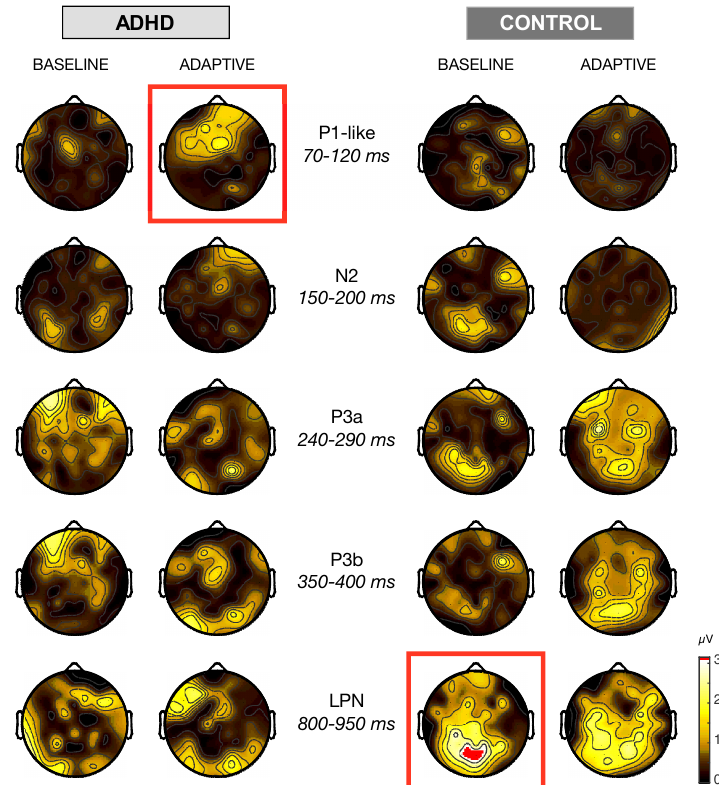
Figure 4. Differential head maps of the topographical distribution of the Grand-Average ERP amplitude (in µ V) at post- minus pre-training sessions for ADHD and controls trained either by the baseline or adaptive protocol of the dual n -back task. ERPs were triggered by the choice of the selected gamble with the button-click. Differential head maps using a color-coded scale in µ V are plotted for the five major ERP time windows. The red squares correspond to those head maps with significant Bonferroni-corrected p -values in the given time window, computed from paired t-tests on the individual average signals (see Figure